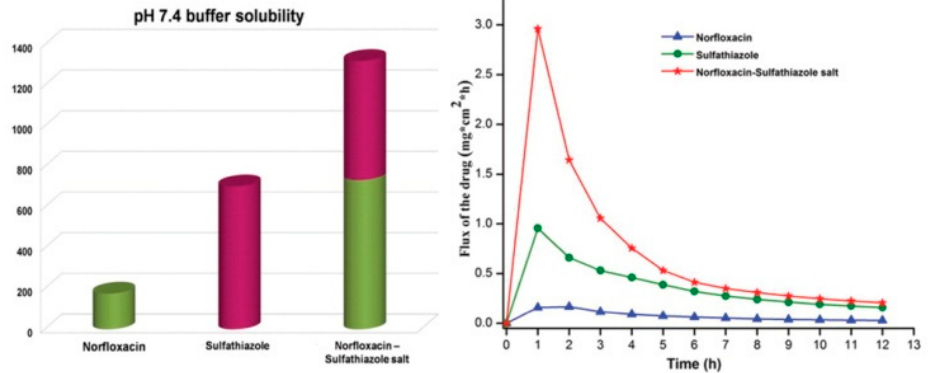
Figure 35. Enhanced solubility and dissolution rate of NF-ST salt hydrate compared to individual drug molecules. Adapted with permission from Molecular Pharmaceutics , 2016, 13, 3590–3594. Copyright 2016, American Chemical Society.